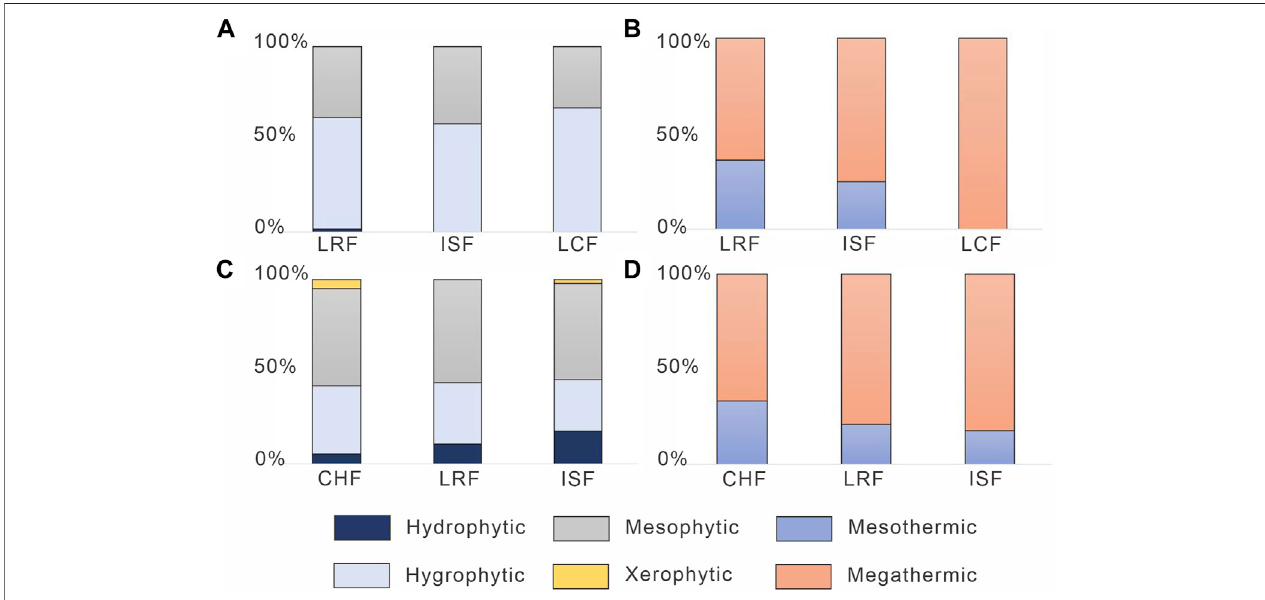
FIGURE 5 | Inferred plant temperature and humidity preference based on previous authors. (A) . Percentages of hydrophytic, hygrophytic, and mesophytic macrofossil taxa. (B) . Percentage of mesothermic and megathermic macrofossil taxa. (C) . Percentages of hydrophytic, hygrophytic, mesophytic, and